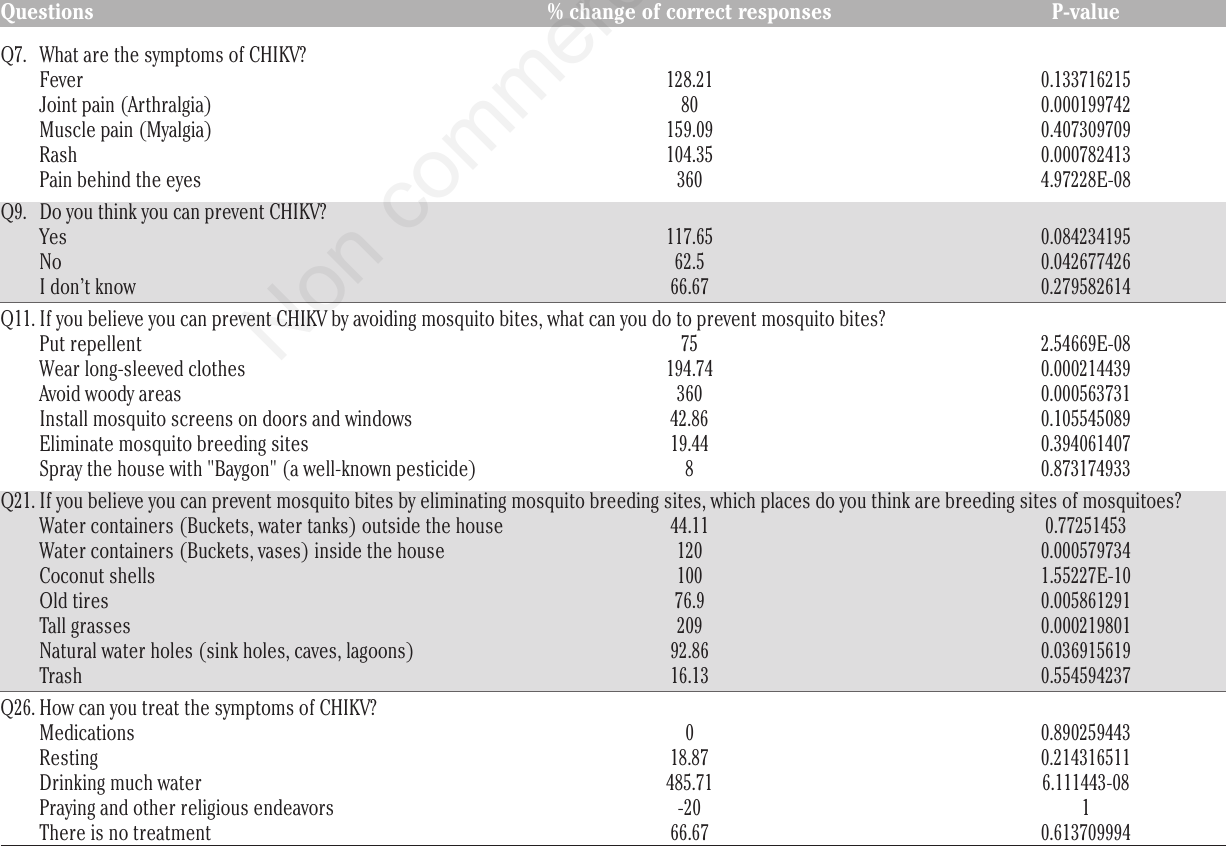
Table 1. Chi-squared test analysis of the Efficacy Questions to test the audience’s knowledge of CHIKV and mosquito prevention meas- ures gained from community-based education module (selective data